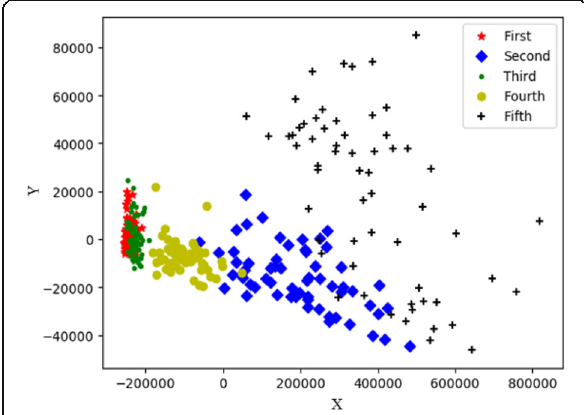
Fig. 7 The distribution of sample data point for five types of gestures. The horizontal axis x represents the first dimensional value, and the vertical axis y represents the second dimensional value in the 2-dimensional feature matrix. The legends first, second, third, fourth, and fifth represent the five kinds of